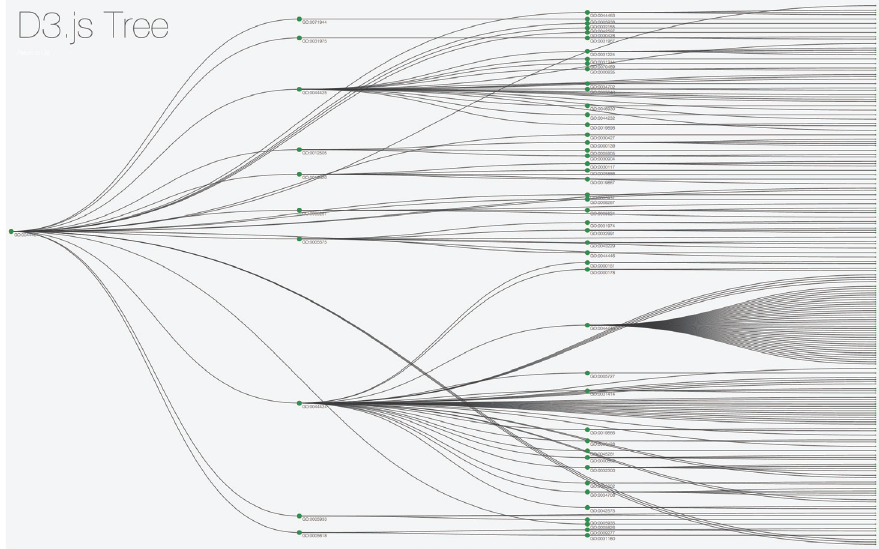
Figure 4. Tree version of Gene Ontology visualized by D3.js tree